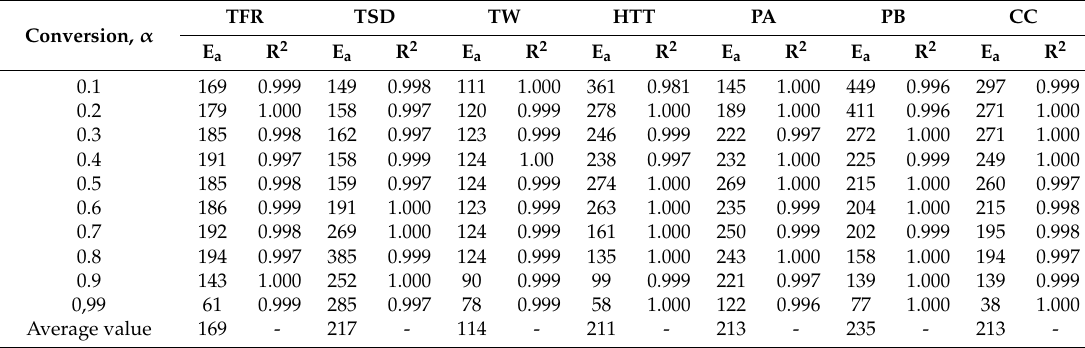
Table 4. Kinetic parameters obtained from the KAS model for different bio-coals, E a , activiation energy in kJ/mol. R 2 , correlation